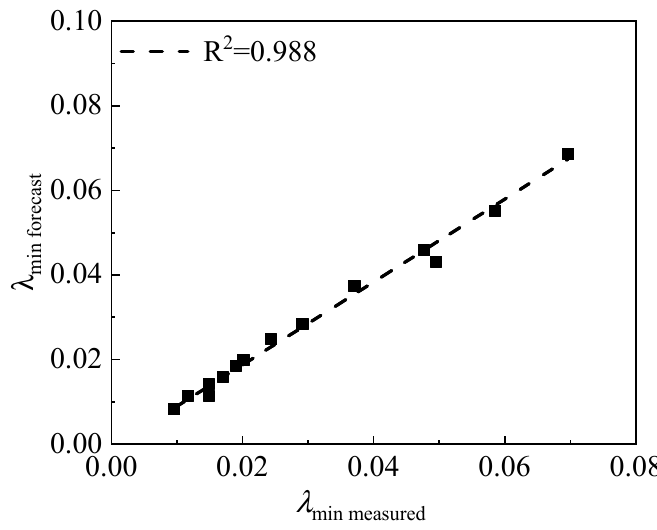
Figure 30. The relationship between the experimental value and the fitting value of the initial damping